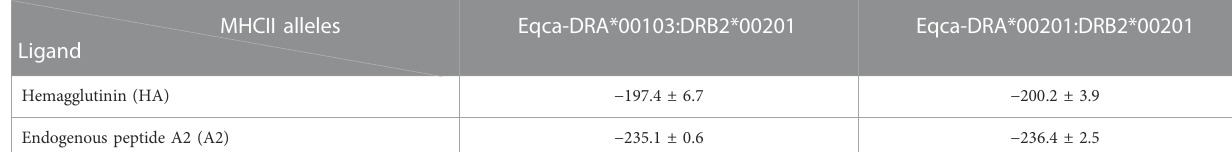
TABLE 1 HADDOCK scores of redocking of two allelic variants of Eqca-DR MHCII models with standard and reference ligand.